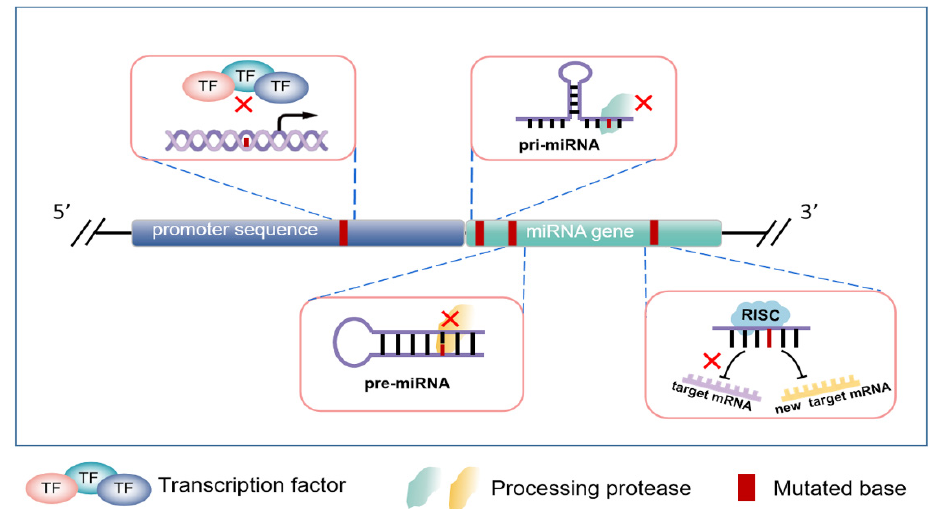
Figure 2. The effect of miRNA genomic mutation in tumors. Base mutation in promoter sequence can affect the binding ability of related transcription factors or change their types. In addition, base mutation in the initial or precursor sequence of miRNA can lead to mislocation and shearing of splicing enzymes. More importantly, base mutation presents in mature miRNA sequence may weaken their inhibitory effect or retarget a new set of